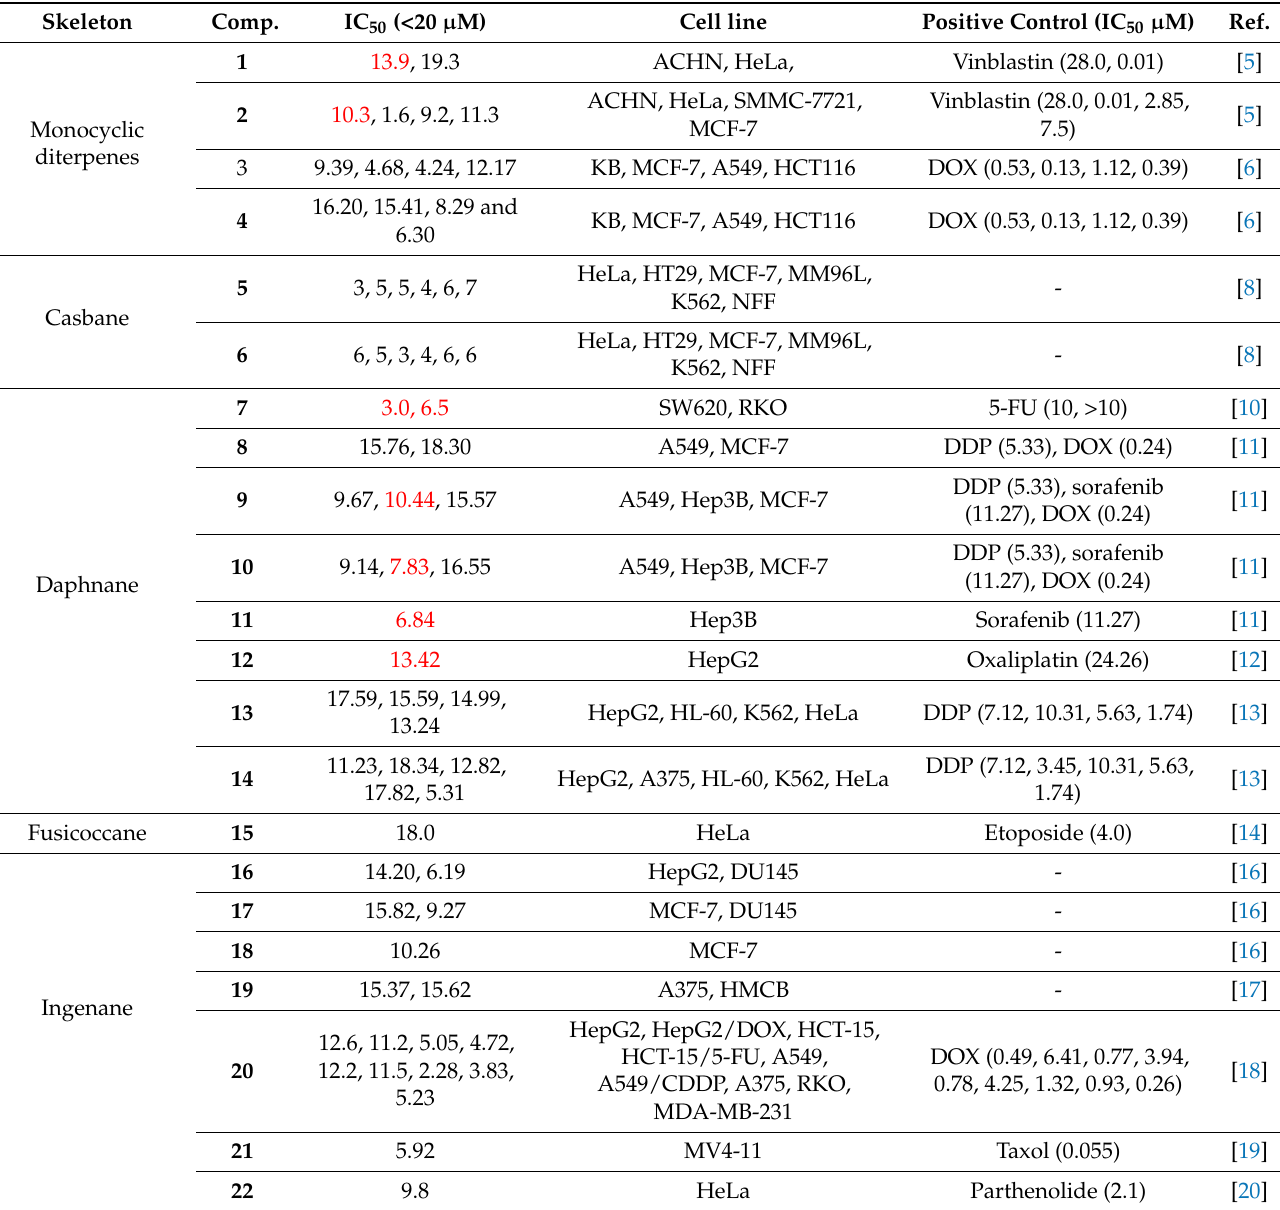
Figure 98. Structures of spirodesertols A 249 [102] and B 250 [102] and tebesinone B 251 [155]. Table 1. List of compounds with cytotoxic activity < 20 µ M (in red, IC 50 values better than the positive control).